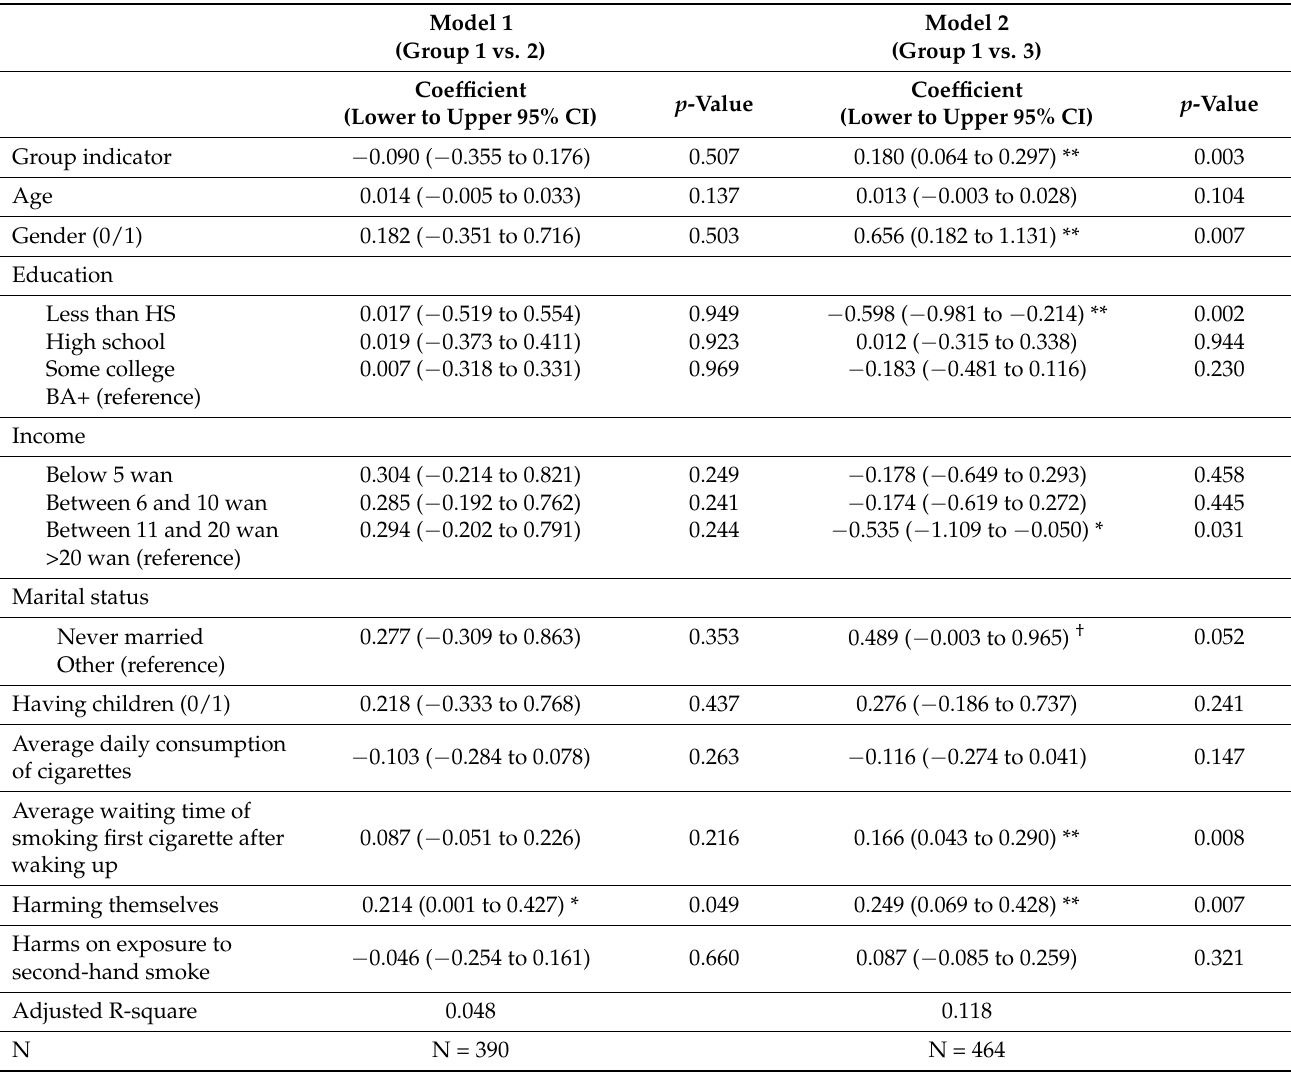
Table 2. Predicting Perceived Harms of Smoking